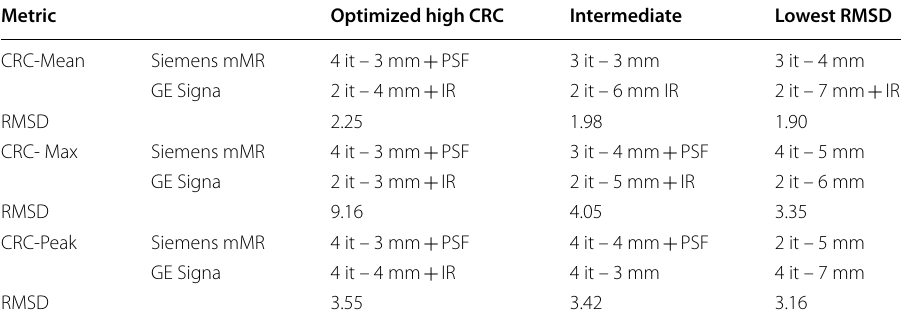
Table 3 Image reconstruction parameters leading to the three optimization criteria CRC and CRC for 5 min data acquisition. All Siemens mMR reconstructions were done with 21 max peak subsets, while all GE Signa reconstructions were done with 16 subsets and TOF (time of